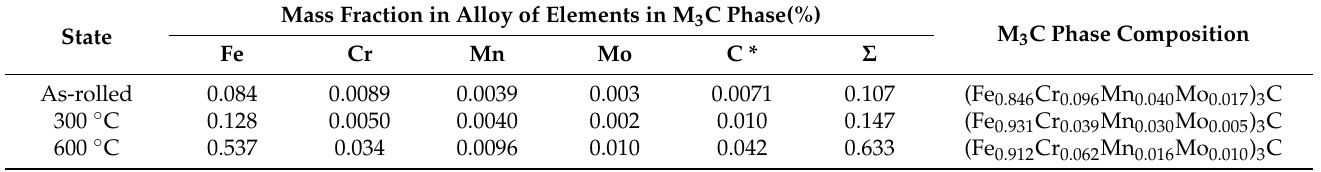
Table 3 indicates the phase analysis results of the M 3 C at different temperatures. The mass fraction of the M 3 C precipitates is lowest in the as-rolled specimen due to a higher cooling rate and a lower laminar cooling temperature. At 300 °C and 600 °C, the MA islands decompose, and the released C atoms increase the mass fraction of M 3 C to 0.147% and 0.633%, respectively. Table 3. The phase analysis results of M 3 C at different temperatures.